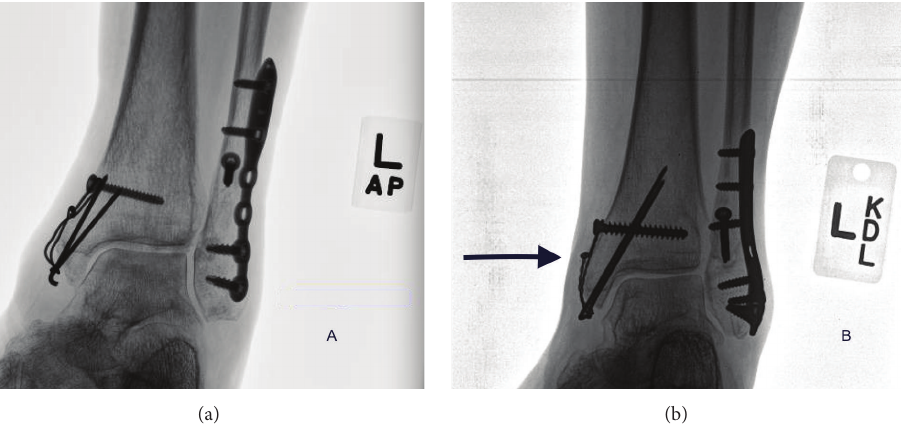
Figure3:(a)demonstratesacommoncomplicationofstainlesssteelwirelooseningfortheWTBandsubsequentirritation.(b)showsstainless steel wire irritation where the wire was cut after tensioning (arrow). Both patients went onto subsequent hardware removal.